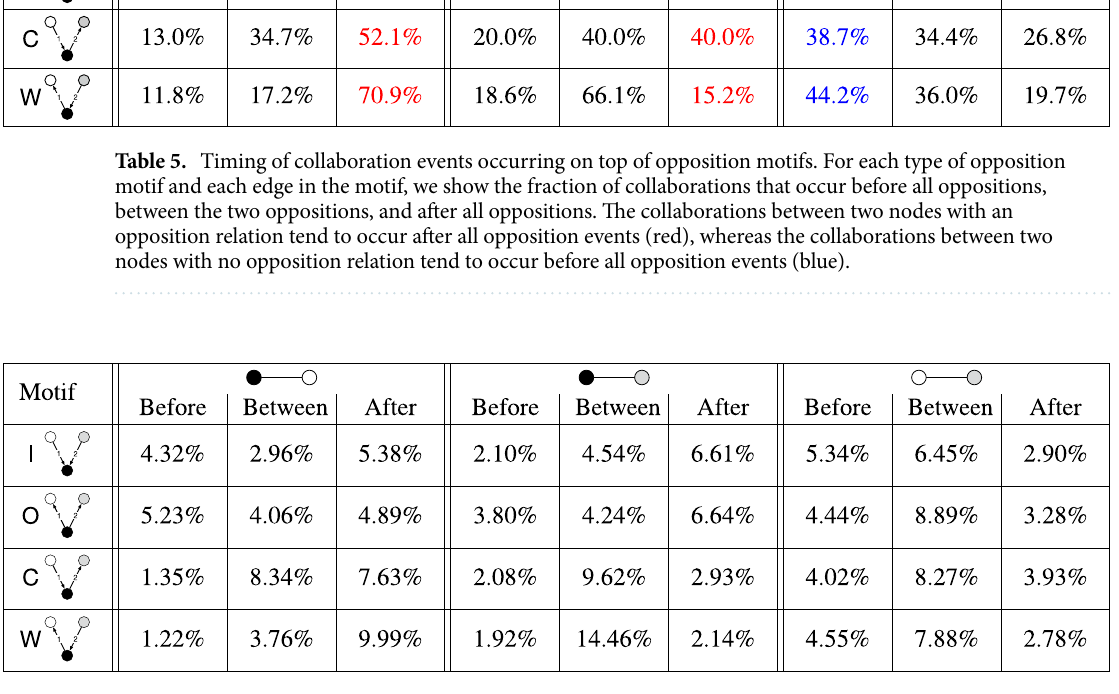
Table 6. Normalized timing of collaboration events occurring on top of opposition motifs. For each type of opposition motif and each edge in the motif, we show the fraction of collaborations per year that occur before all oppositions, between the two oppositions, and after all oppositions. For each interval, the fraction is normalized by the length of the